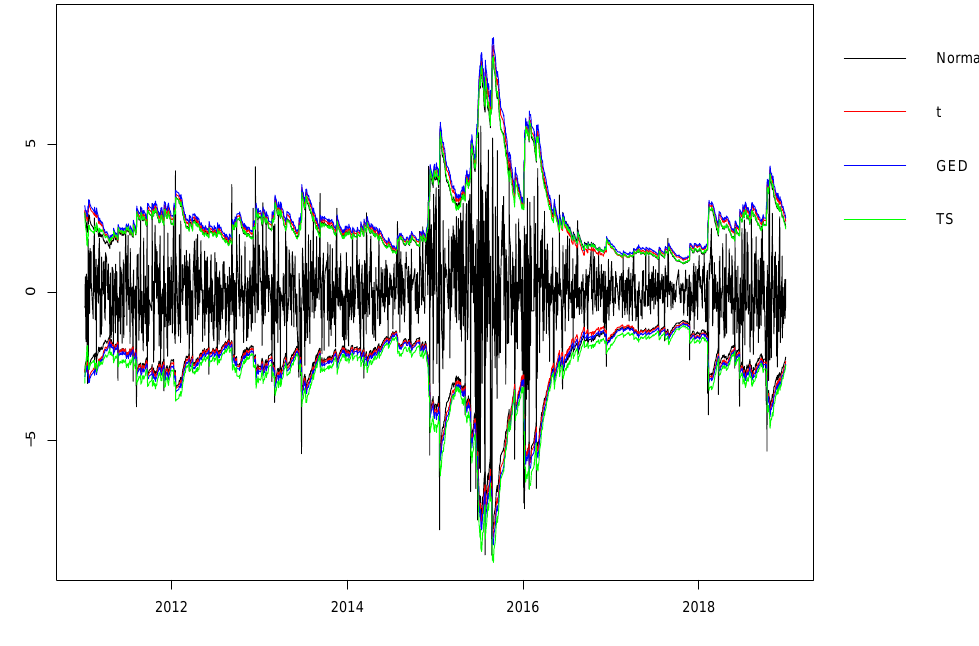
Figure 3. Value-at-risk